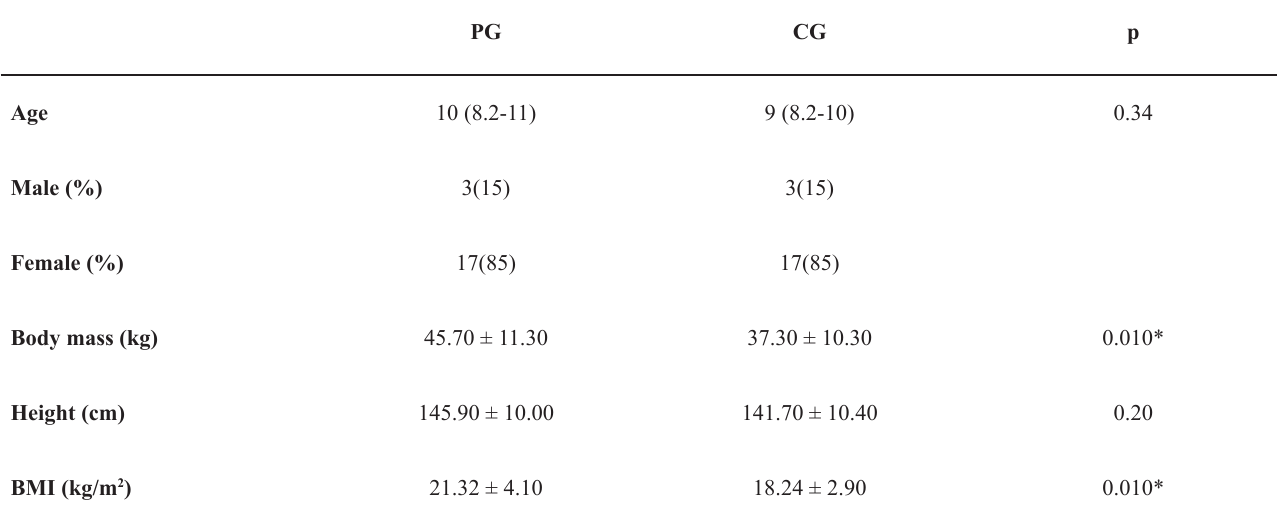
Table 1 - Characteristics of